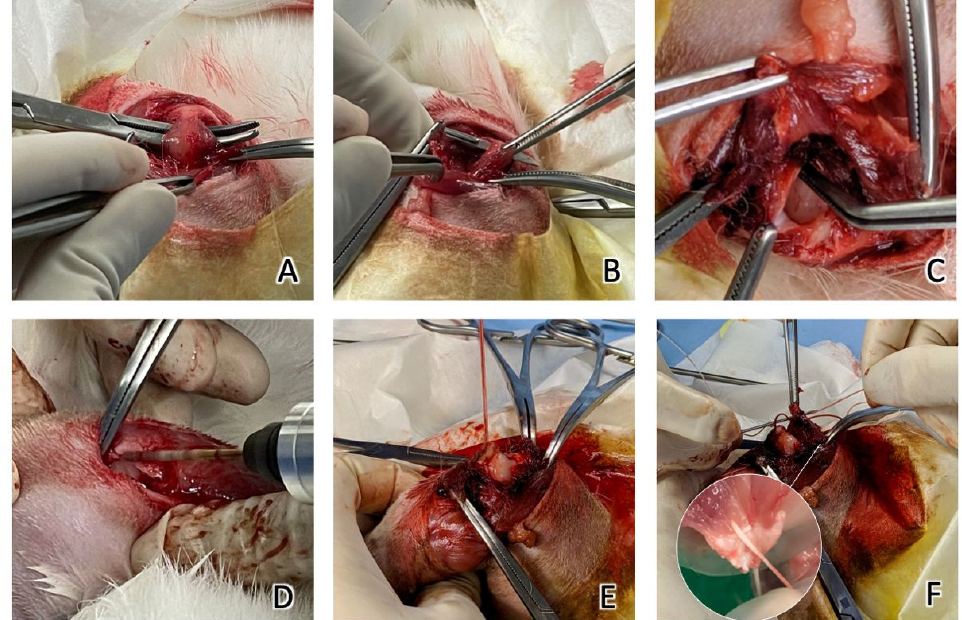
Figure 3. ( A ) The SST of the rabbit was identified. ( B ) The SST was sharply dissected with a scalpel blade and ( C ) the SST was detached from the insertion of the humerus. ( D ) A drill bit was used to predrill a hole in the humerus insertion of the SST. ( E ) After inserting the SA, the two ends of the suture exited from the SST insertion. ( F ) The SST was repositioned to the footprint using a modified Mason–Allen stitch.